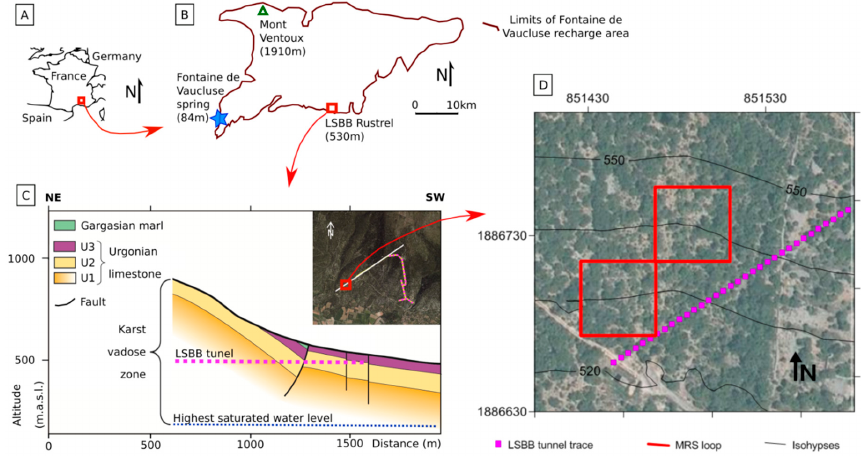
Figure 1. Location of ( A ) test site in France; ( B ) in the Fontaine de Vaucluse recharge area; ( C ) schematic cross-section across LSBB; ( D ) overview of the respective locations of the surface NMR (SNMR) loop and LSBBtunnel(coordinatesystem: LambertII é tendu);isohypsesevery10m(http: //